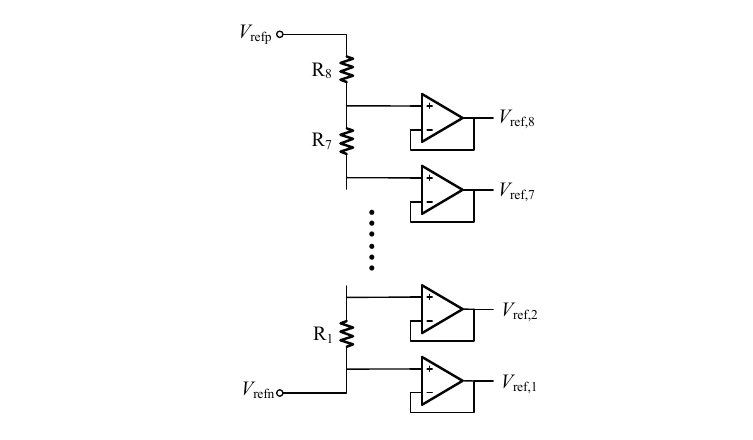
Figure 15. The reference generator based on a resistor